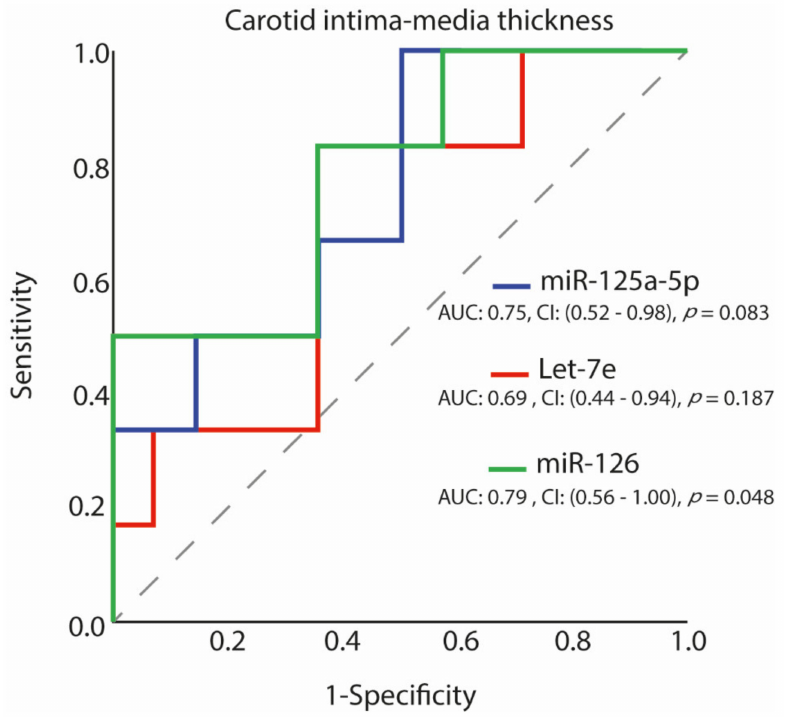
Figure 2. Receiver operating characteristic (ROC) curves of miR-125a-5p, Let-7e, miR-126 prediction of increased CIMT.